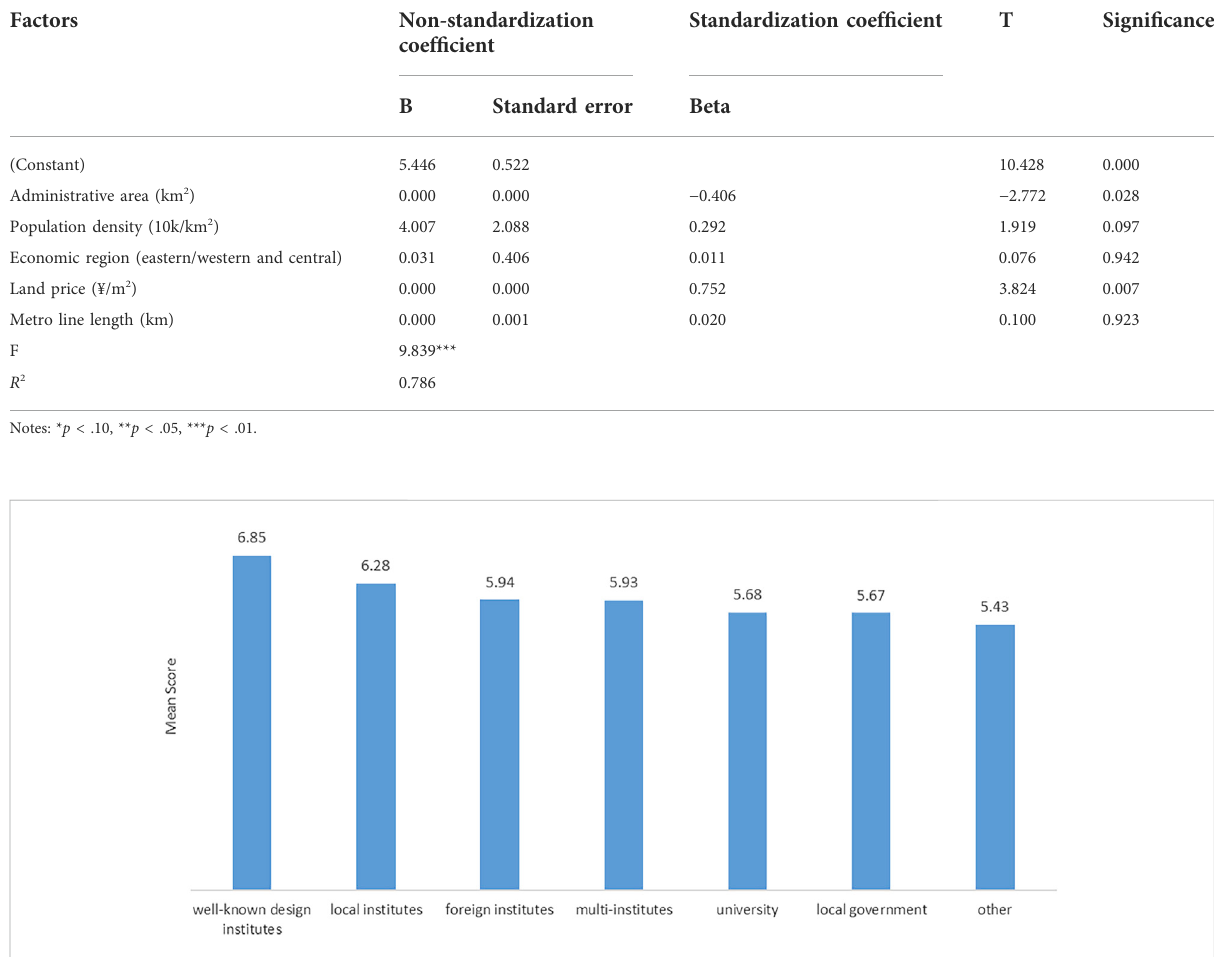
FIGURE 8 Mean scores for plan quality and the local planning